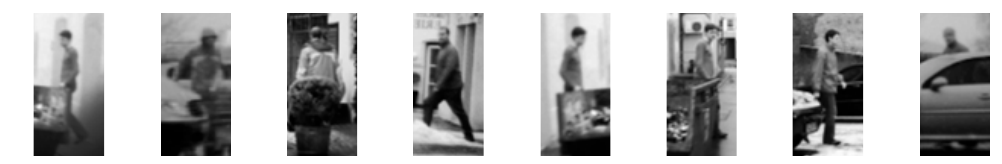
( c ) Figure 6. Examples of pedestrian images with random block occlusion. ( a ) 20% block occlusion; ( b ) 30% block occlusion; ( c ) 40% block occlusion. Table 5 lists the classification results versus various levels of occlusions. Here λ of HFE − WKSR is set as 0.1. From Table 5, we can see that almost all methods could correctly classify most of the testing samples when occlusion level is from 10% to 20%. However, when occlusion percentage is larger than 20%, the advantage of HFE − WKSR over other methods becomes significant. For instance, when occlusion is 40%, HFE − WKSR could achieve at least 84% recognition accuracy, compared with at most 72.5% for other methods. For HFE − WKSR, when there is 50% block occlusion, it can still achieve a recognition rate of over 75%. This clearly demonstrates the effectiveness of the proposed HFE − WKSR method to deal with partial occlusion. Table 5. Classification results on block occlusion. Occlusion